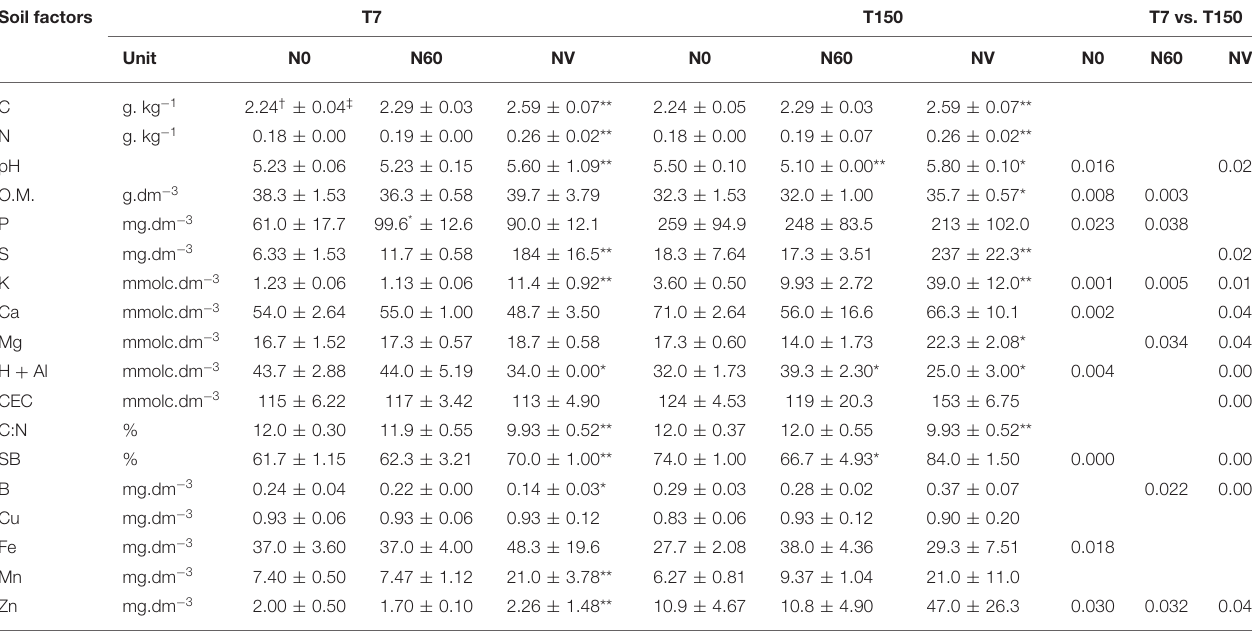
TABLE 1 | Chemical compounds present in the soil treatments without nitrogen fertilization (N0), with nitrogen fertilization (N60), and with nitrogen fertilization combined with vinasse (NV) collected at seven (T7) and one hundred fifty (T150) days after the start of the experiment. Soil